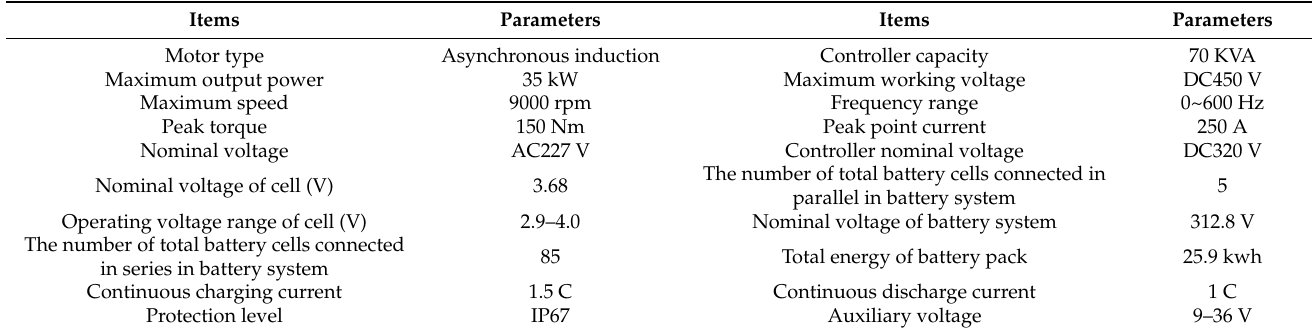
Figure 7. BEV powertrain system and its subsystem Table 2. Performance parameters of BEV powertrain system.